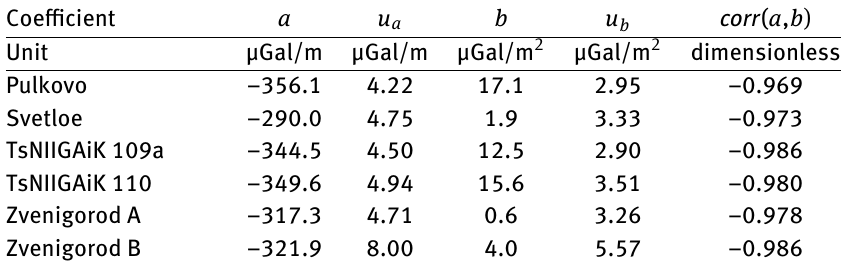
Table 4: Approximation of gravity as a function of height z above the station marker, using a second-degree polynomial g ( z ) − g (0) = az + bz 2 fitted by least squares to relative gravity observations. Here u corr ( a , b ) is their correlation. The gravity difference between two heights z 1 and z 2 is then estimated by ∆g = g ( z 1 ) − g ( z 2 ) = a ( z 1 − z 2 ) + ) and its standard uncertainty as m ( ∆g ) = [ u 2 − z 2 b ( z 2 1 2 correlation between a and b is caused by the choice of the station marker as the origin of the z -values: the marker is well outside the height range where the relative measurements are actually taken.